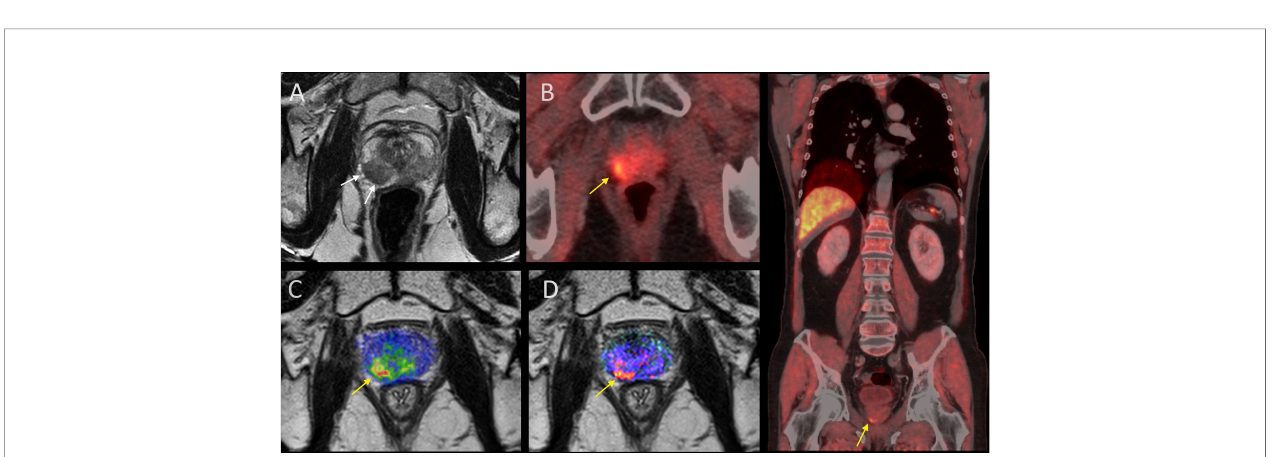
FIGURE 2 | Primary and radio-recurrent prostate cancer at imaging. (A) Primary tumor at T2W MRI (white arrows). (B – D) Recurrent tumor (yellow arrow) at FACBC PET/CT, diffusion weighting overlaid on T2W MRI, and dynamic contrast-enhanced MRI overlaid on T2W MRI. To the right: Whole-body FACBC PET/CT to prove true local recurrence only (yellow